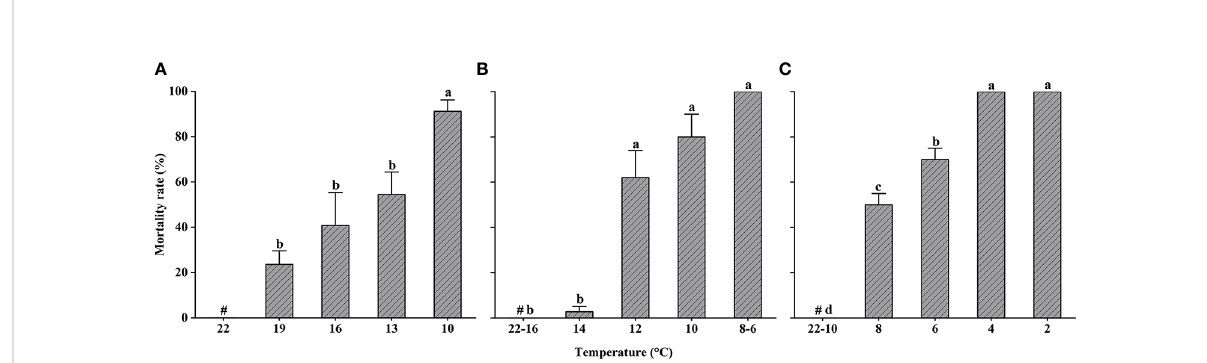
FIGURE 3 Larimichthys crocea yolk-sac larvae (A) , larvae (B) , and juvenile (C) mortality rate in cold-shock treatments (mean ± SD). Labeled means without a common letter differ ( P < 0.05). # Control